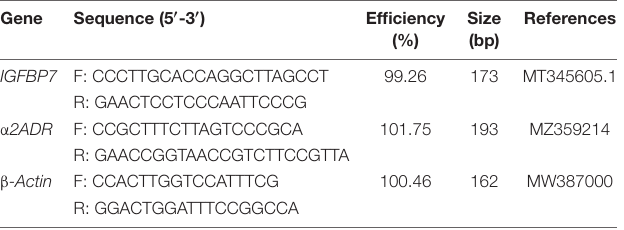
TABLE 1 | Oligonucleotide primers used in